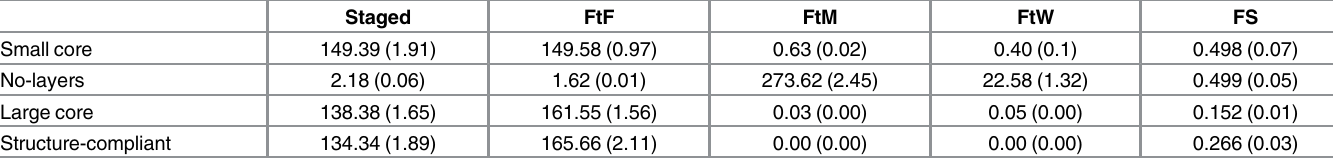
Table 4. Average (standard deviation) number of agents by strategy for each of the four social pattern outcomes in 50 simulations.